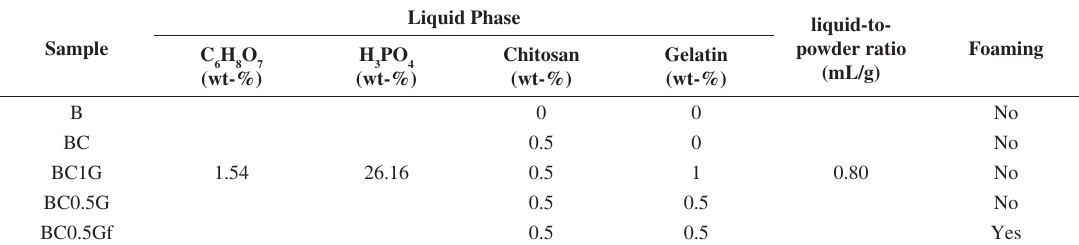
Figure 1. Compressive strength of samples as a function of porosity. Figure 2. SEM micrographs of samples’ surface of Table 1. CPC and scaffold formulation.